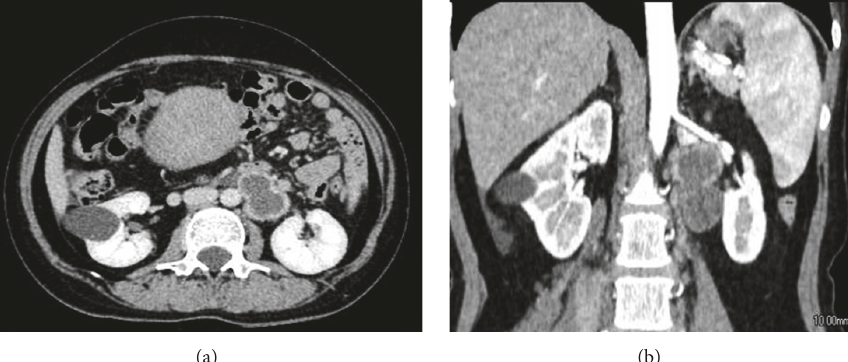
Figure 1: Computed tomography scan showing that the bilocular cystic mass is located caudally from the left renal hilus without solid parts.